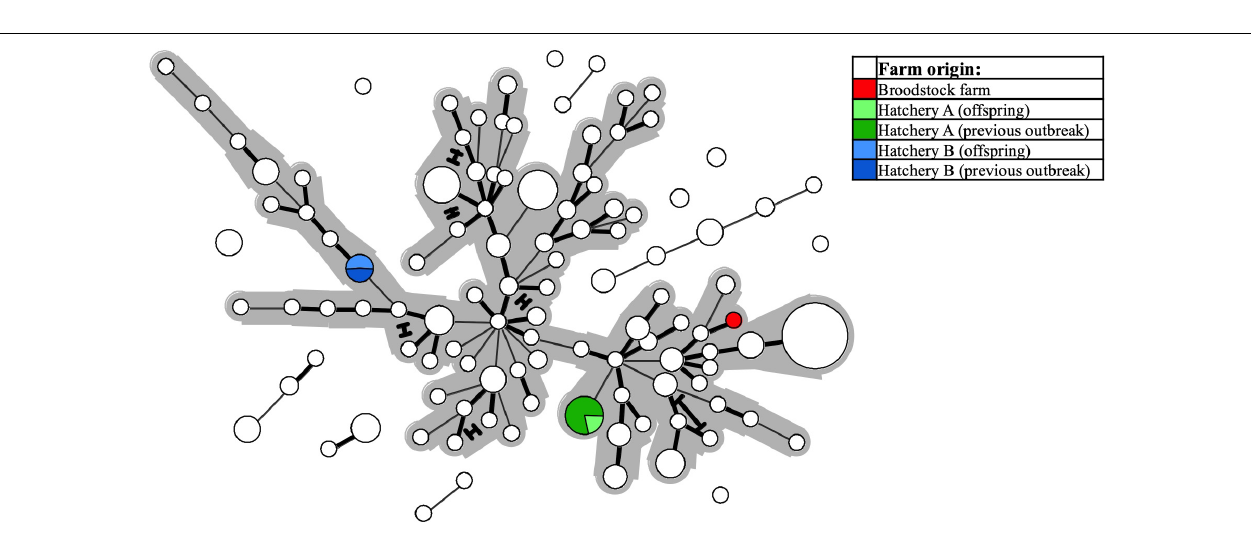
FIGURE 6 | The same Minimum-spanning-tree as presented in Figure 4 , but with coloring (see legend) here reflecting specific farm origins – i.e., from a single Atlantic salmon broodstock farm, or from either of two hatcheries, both of which experienced SGPV disease outbreaks in offspring from said broodstock farm, and also in thus unrelated, noncontact fish